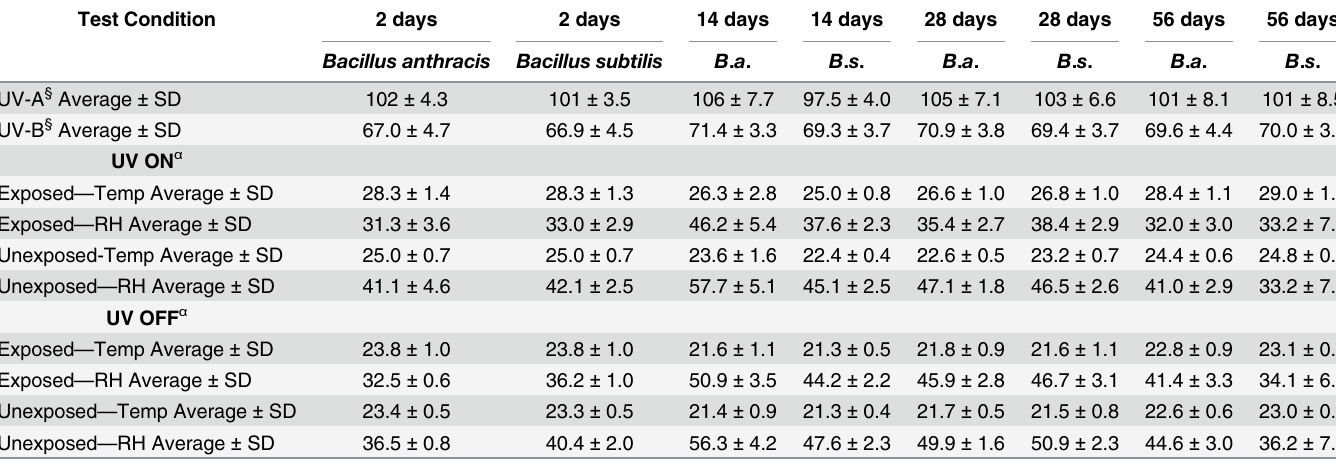
Table 1. Summary of environmental conditions for each experiment.